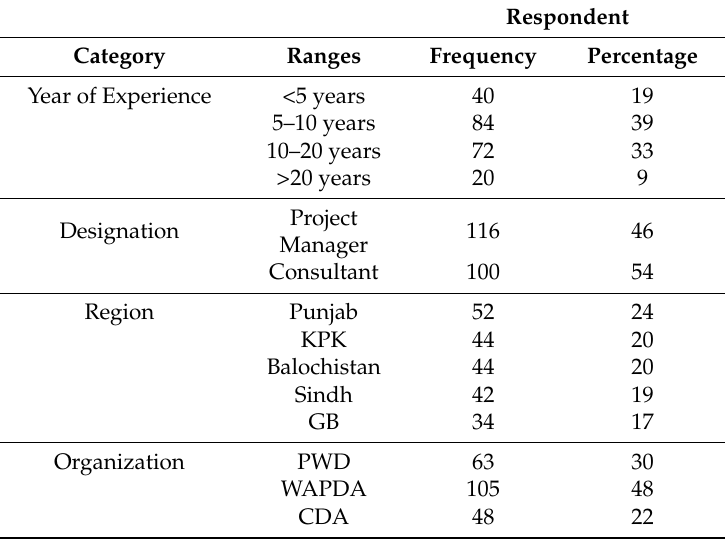
Table 2. Summary of Respondents